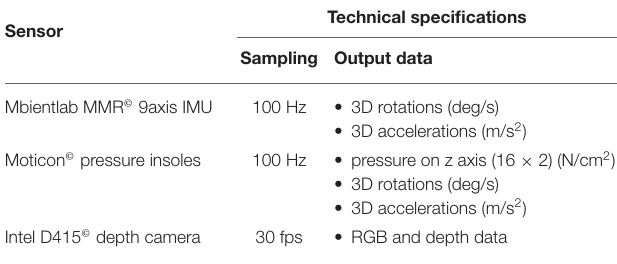
TABLE 3 | Sensors included in the sensing platform.